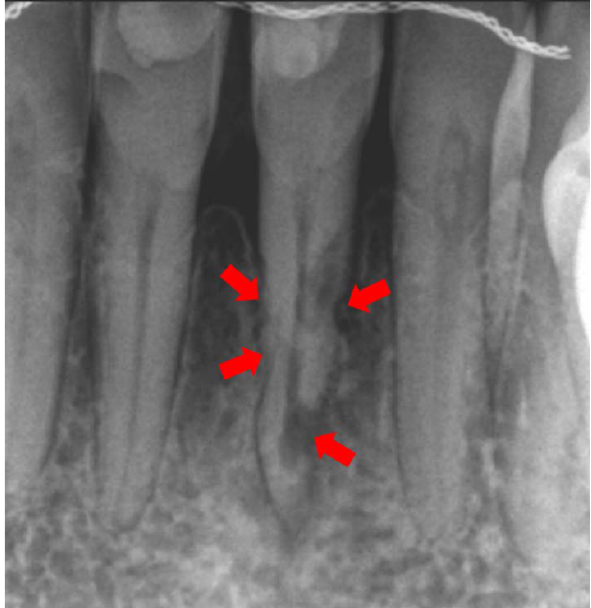
Figure 2. Periapical radiograph of tooth #24. Extensive resorptive defect observed on multiple areas of the dental root. The prognosis for this tooth was deemed guarded due to advanced ERR.